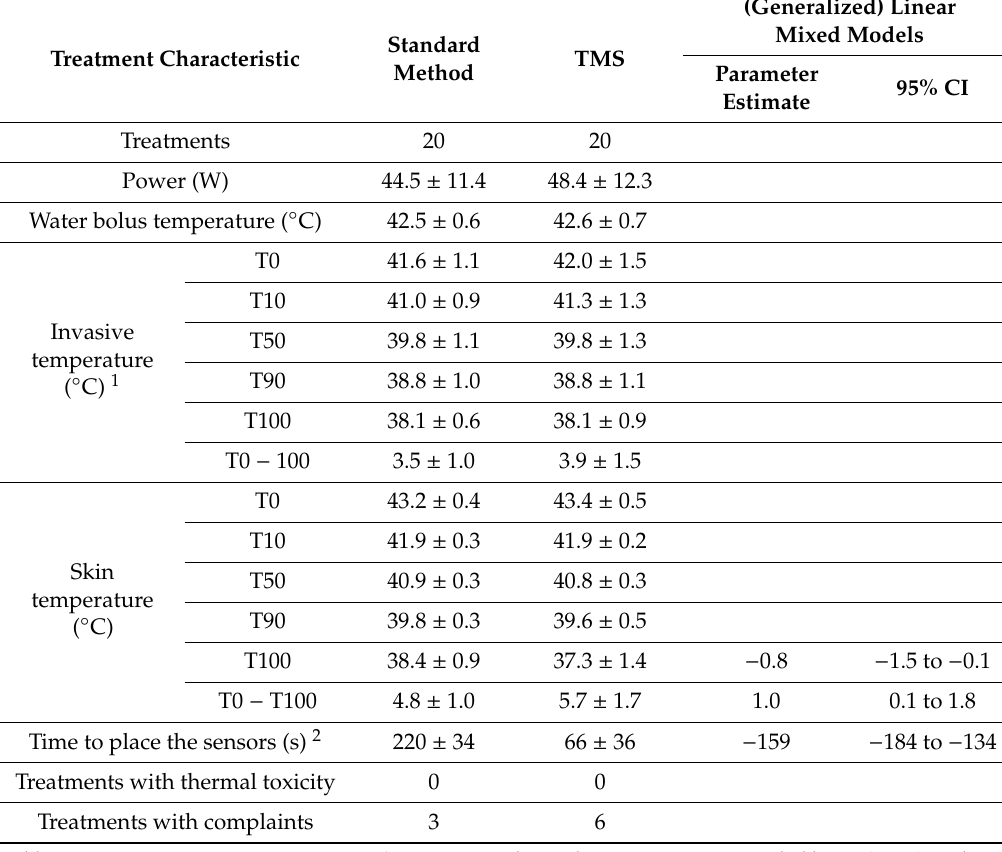
Table 4. Treatment characteristics of 10 patients for treatments with the standard skin surface thermometrymethodoftheAmsterdamUniversityMedicalCenterscomparedtothethermalmonitoring sheet (TMS). The results of the (generalized) linear mixed models were presented.